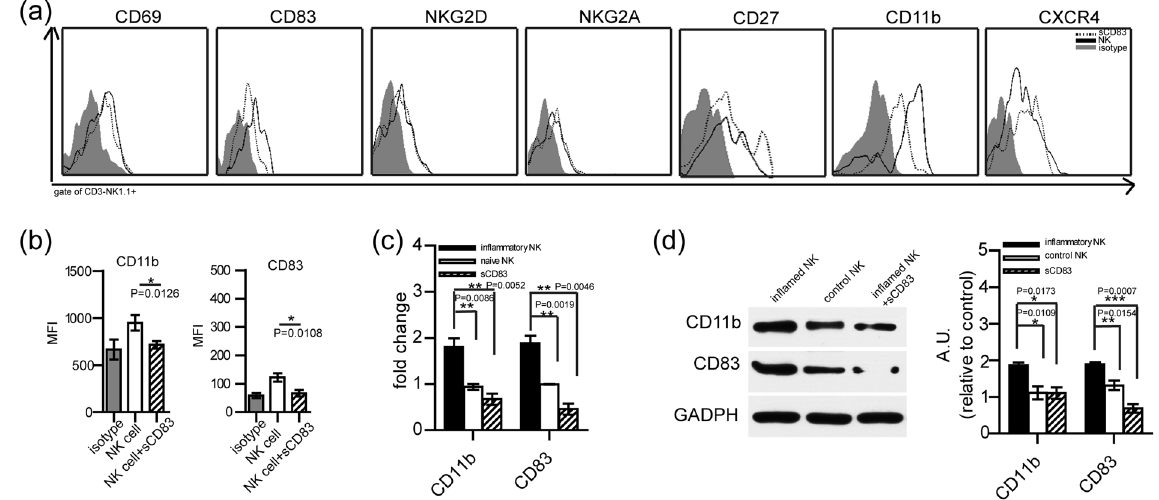
Figure 4. Expressions of CD11b and CD83 in NK cells following sCD83 treatment was analyzed in vitro . ( a ) Expressions of CD69, CD83, NKG2D, NKG2A, CD11b, CD27 and CXCR4 in NK cells with or without sCD83 treatment. ( b ) Mean fluorescence values of CD11b and CD83 in CD3 − NK1.1 + cells with or without sCD83 treatment (three separate experiments were repeated, values represent the mean ± s.e.m., CD11b: P = 0.0126, CD83: P = 0.0108). ( c ) Quantitative real-time reverse-transcriptase–PCR (qRT–PCR) of CD11b and CD83 expression in isolated NK cells from EAU mice (black bar), naive mice (open bar) and sCD83 treated isolated NK cells from EAU mice (gray bars) (mean ± s.e.m. ** P < 0.01). ( d ) Western-blot analysis of CD11b, and CD83 expression in isolated NK cells from EAU mice (black bar), control mice (open bar) and sCD83 treated isolated NK cells from EAU mice (gray bars) (values represent the mean ± s.e.m. * P < 0.05, ** P < 0.01, *** P <